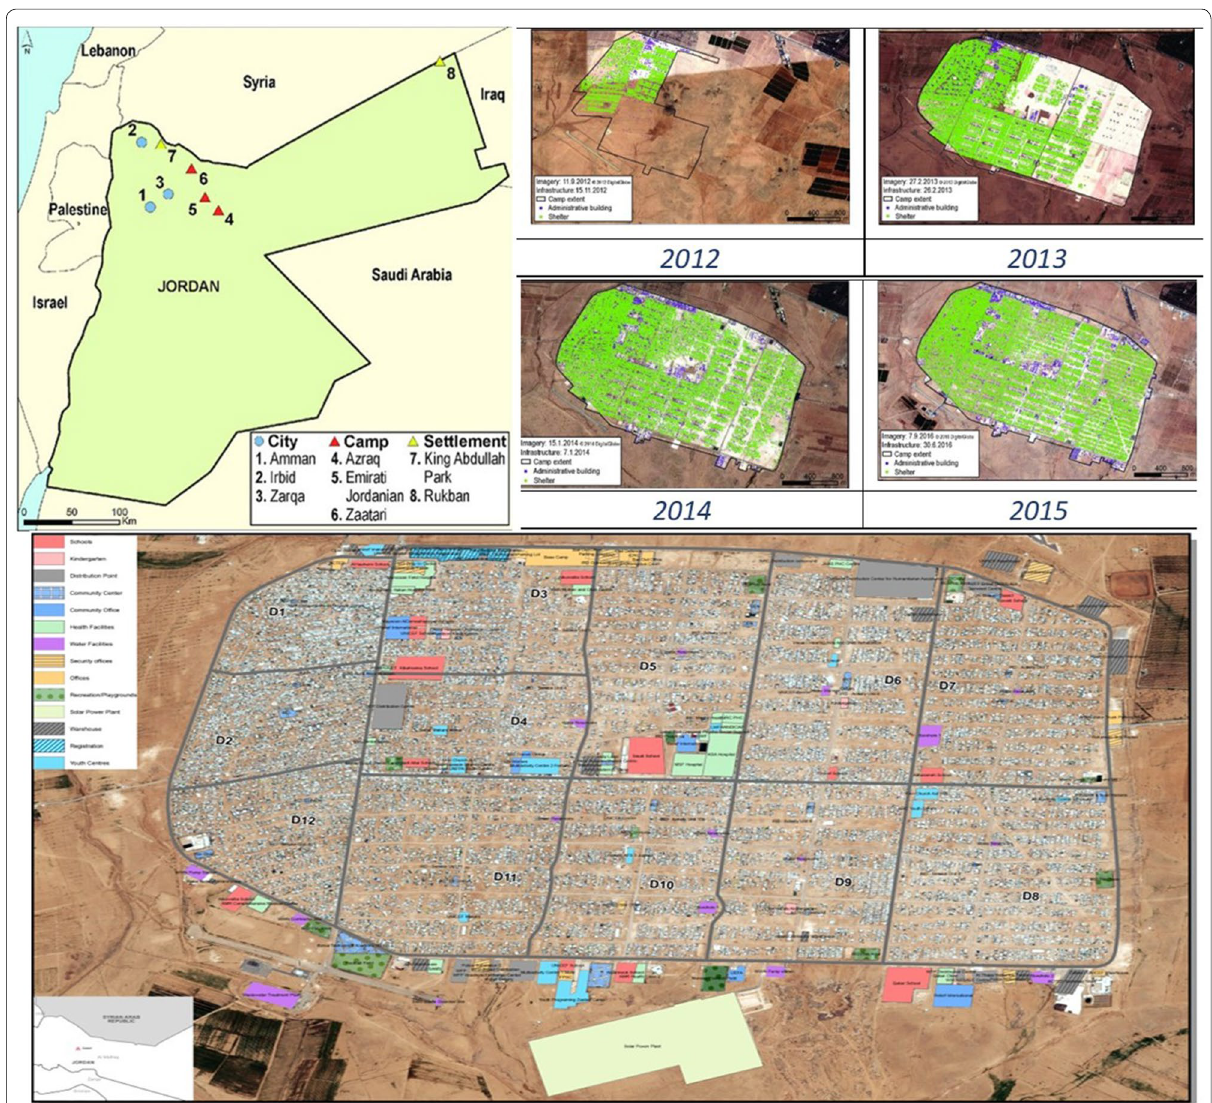
Fig. 2 (Top left) Syria border with Jordan and Al Za’atari refugee camp location (Source: Jussi and Vorobeva (2017), (top right) The Al Za’atari camp between 2012 and 2015 (Source: (Jussi and Vorobeva, 2017), (bottom) Al Za’atari refugee camp districts in 2019 (Source: (UNHCR